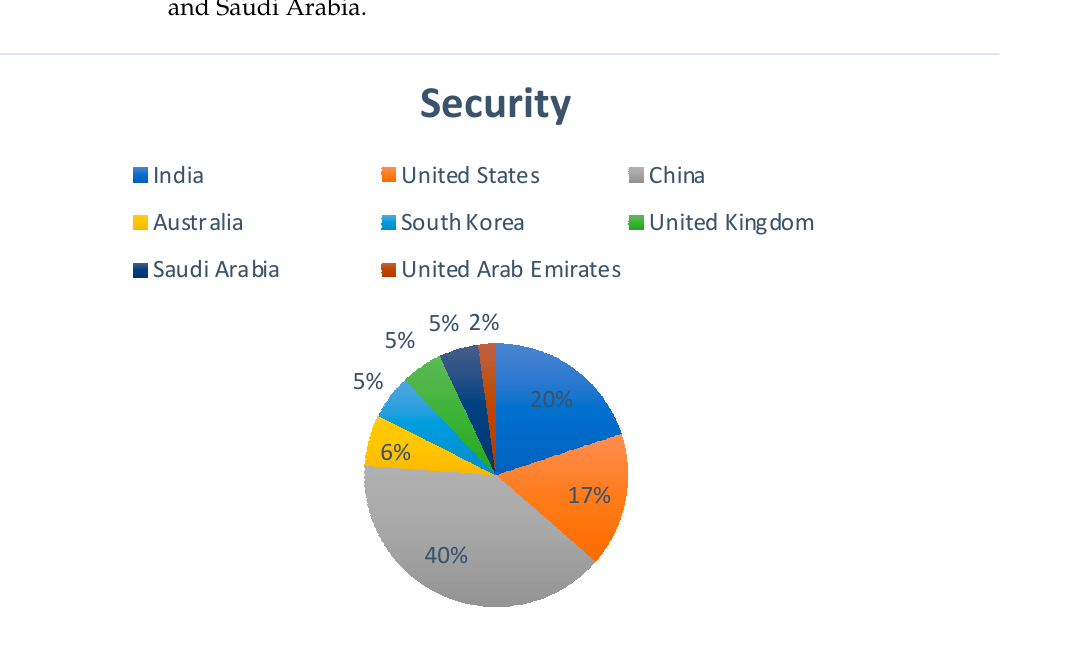
Figure 8. Region-specific publication distribution for Blockchain–Cloud and Smart Cities.